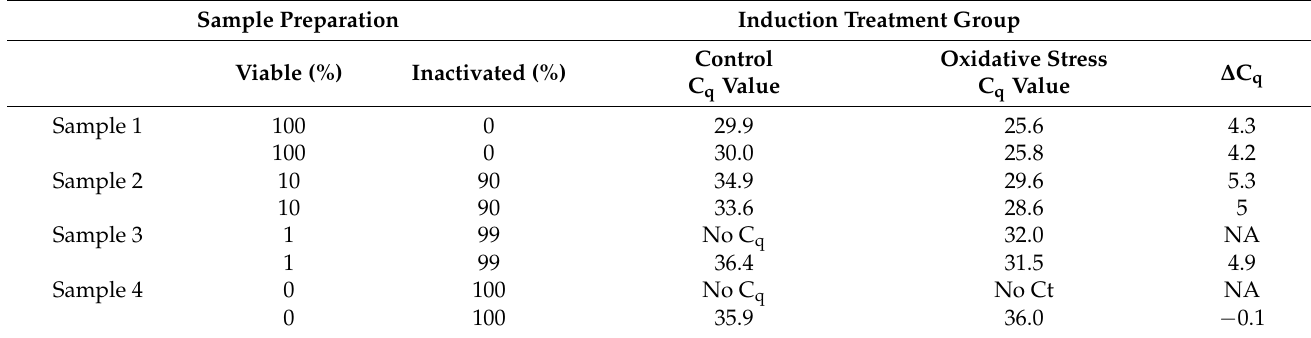
Table 4. Evaluation of the RT-qPCR targeting thioredoxin by using mixtures of viable and inactivated oocysts of C. parvum . Sample Preparation